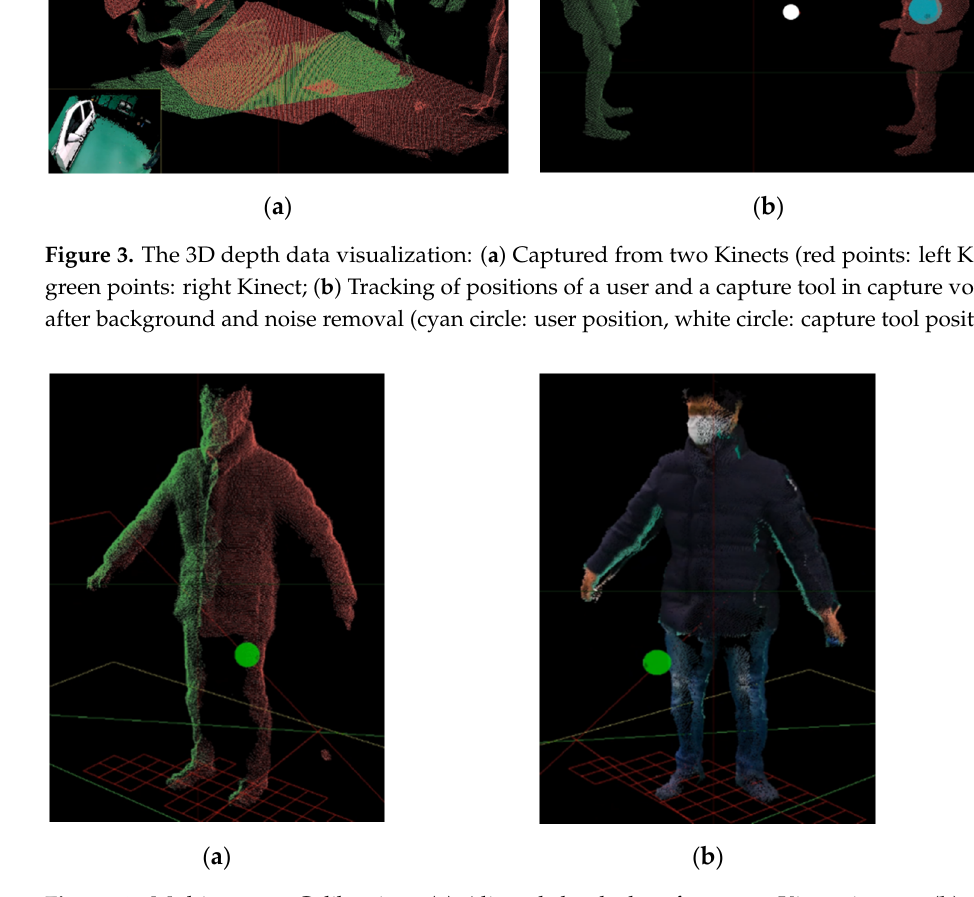
Figure 4. Multi-camera Calibration: ( a ) Aligned depth data from two Kinect inputs; ( b ) Color data result.